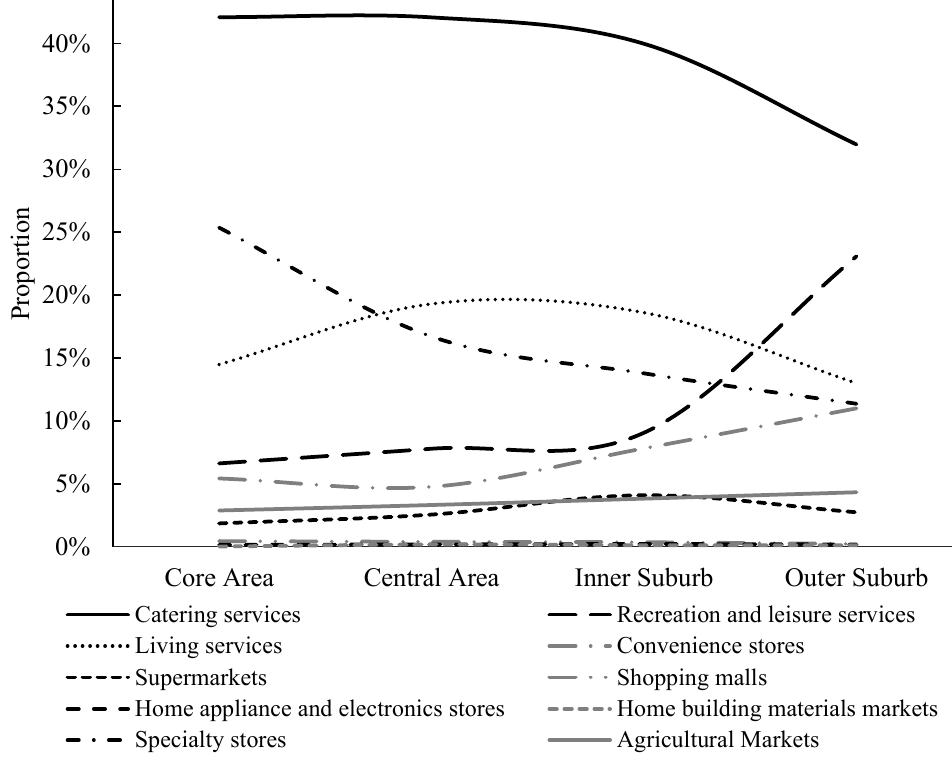
Figure 4. Spatial circular distribution of the various commercial formats in Beijing.